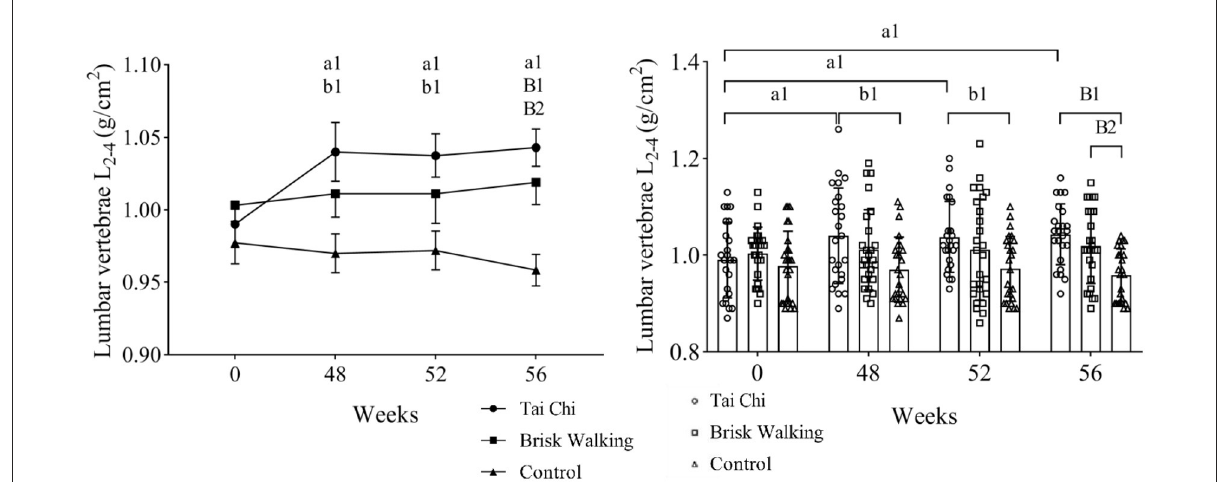
FIGURE2 Bone mineral density of lumbar vertebrae L 2 − 4 . Fifty-two weeks is 4 weeks after exercise cessation, and 56 weeks is 8 weeks after exercise cessation. Tai Chi group intra-group comparison, in the comparisons of week 48, week 52, week 56 vs. week 0, a1 indicate differences of P < 0.05. Tai Chi group compared with the control group at the same timepoint, b1 indicate differences of P < 0.05, while B1 indicate differences of P < 0.01. Brisk Walking group compared with the control group at the same timepoint, B2 indicate differences of P <